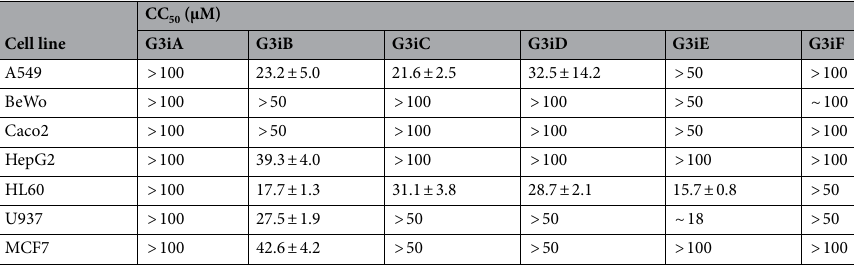
Table 3. CC 50 of GLUT3 inhibitors in various cancer cell lines determined from MTT assays. The concentration of compound that resulted in 50% reduction cell viability compared to control (i.e., 50% cytotoxic concentration or CC 50 ) was determined for G3iA-G3iF. GLUT3 inhibitors at concentrations ranging from 2 to 100 µM were incubated for 48 h with leukemia cell lines (HL60, U937), A549 (lung cancer), BeWo (choriocarcinoma), MCF7 (breast cancer), HepG2 (liver cancer), and Caco-2 (colon cancer) cells. Cell viability was determined with the MTT assay (data in Supplementary Fig. S8). CC 50 values were determined in GraphPad (https:// www. graph pad.